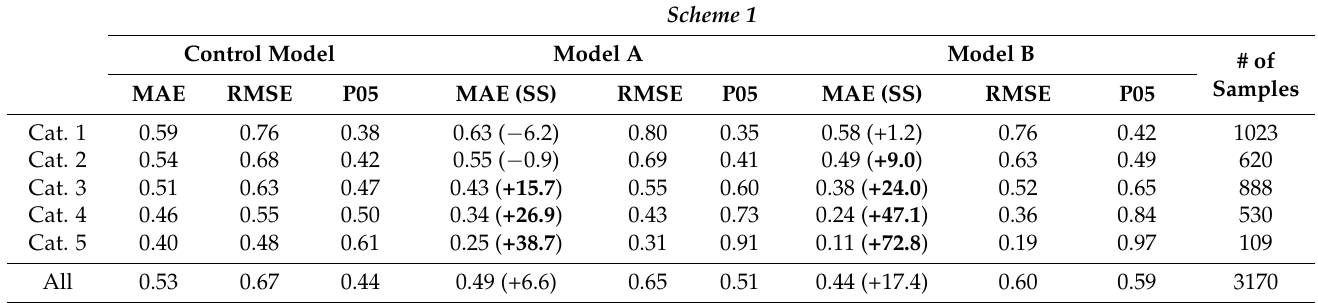
Table 4. Evaluation results of scheme-1 -based tropical cyclone center estimation. Scheme 1 used the forecasting reports issued from the Korea Metrological Association 6 h prior. The unit of mean error (ME), mean absolute error (MAE), and root mean squared error (RMSE) is degrees ( ◦ ), and P05 is unitless. The unit of skill score (SS) is percentage (%), which implies the improvement of models A and B compared to the control model based on SCBeM . The improved cases are shown in bold.